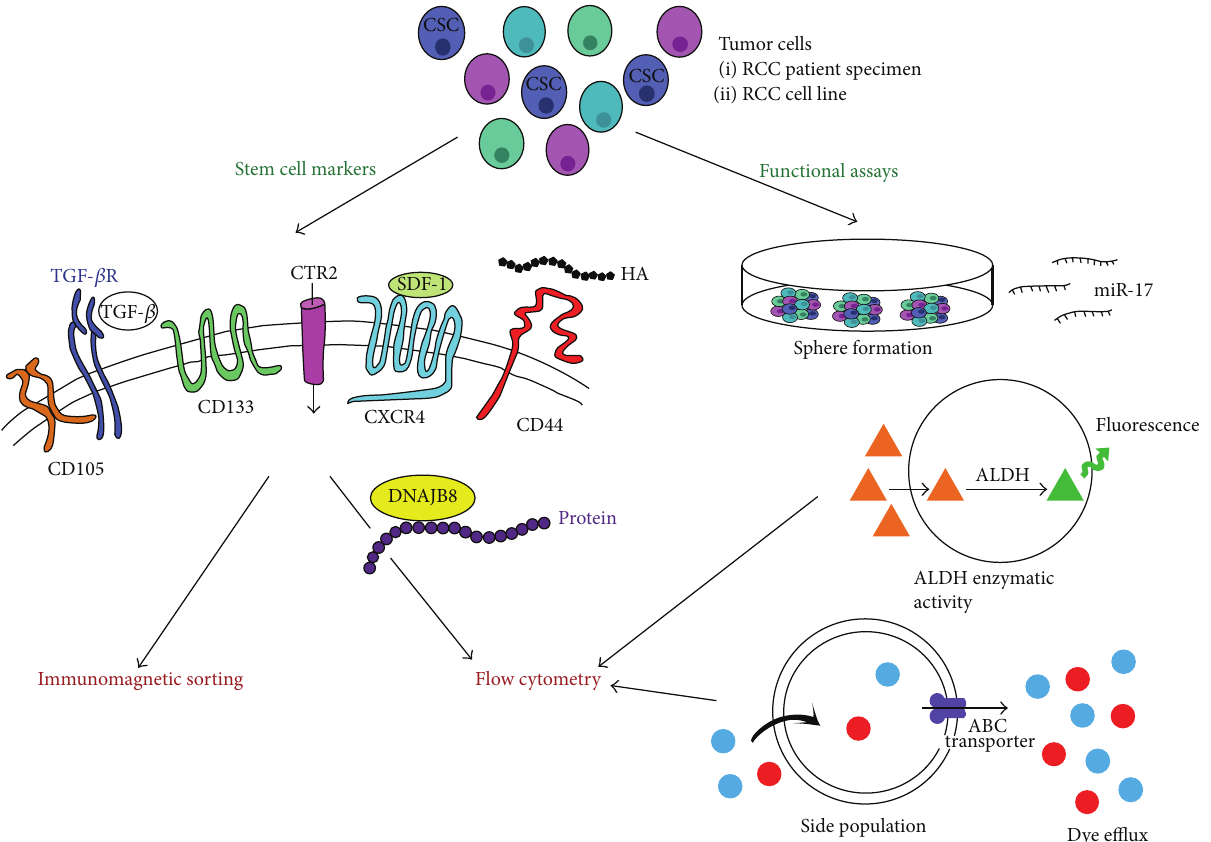
Figure 2: Identification of cancer stem cells using stem cell markers and functional assays. Several techniques have been described to identify cancer stem cells (CSCs) and to isolate them by immunomagnetic sorting, flow cytometry, or cell culture. HA: hyaluronic acid; red circle: Hoechst 33342; blue circle: Rhodamine 123; ALDH: aldehyde dehydrogenase; orange triangle: BODIPY-aminoacetaldehyde (substrate); green triangle: